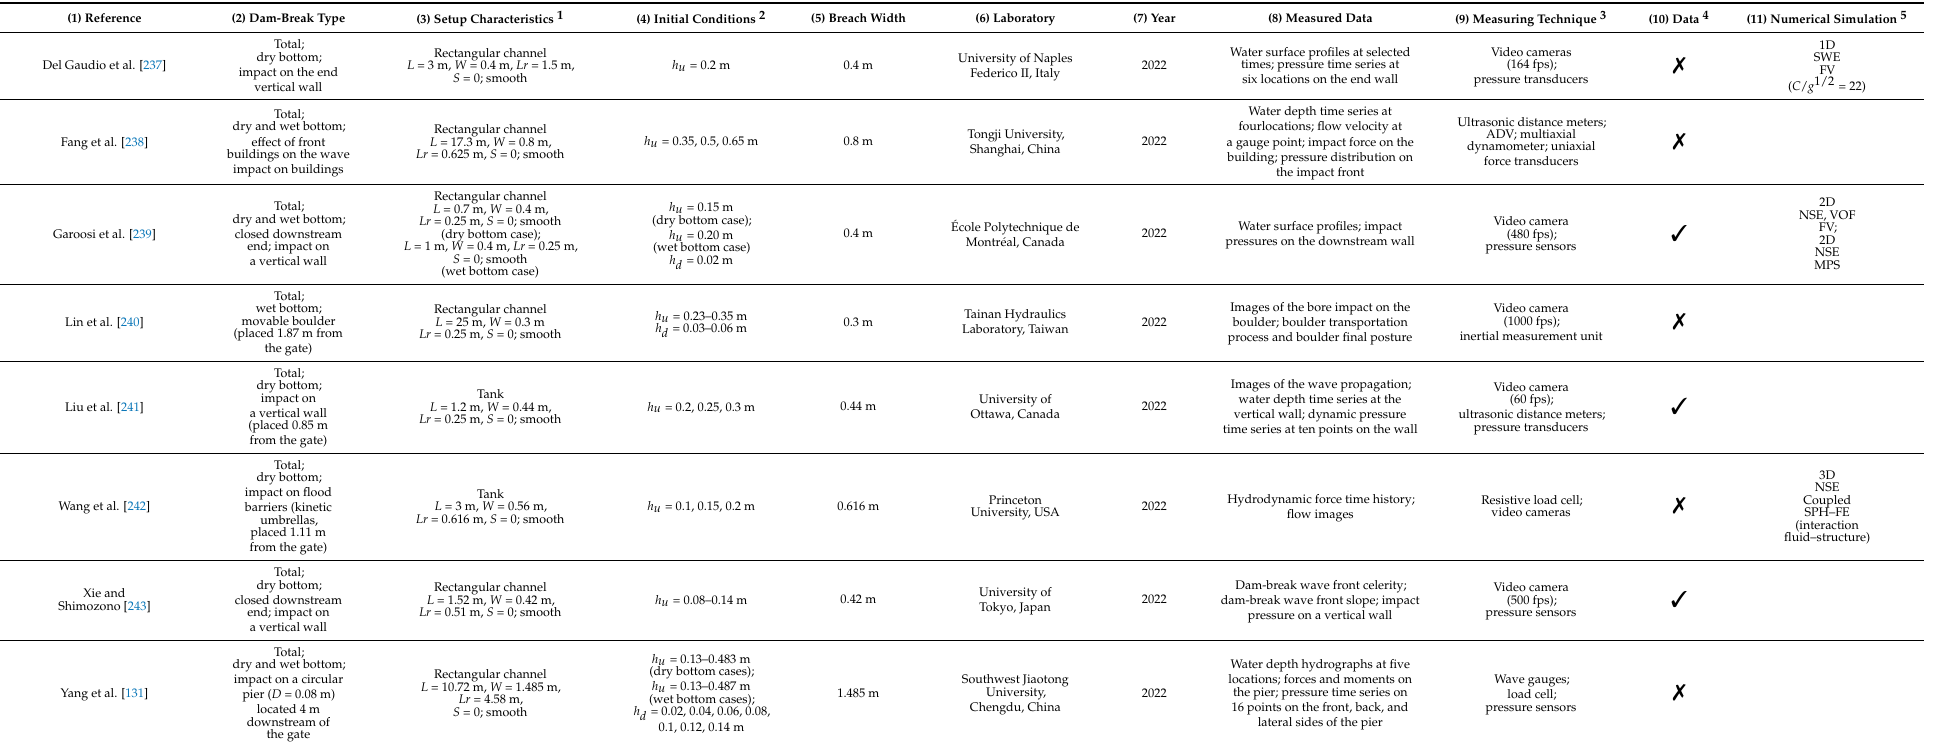
Table 1. Basic experimental investigations of fundamental dam-break wave physical